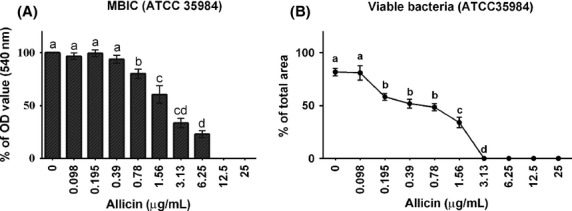
Minimum biofilm inhibitory concentration (MBIC) and viability of Staphylococcus epidermidis (ATCC 35984) within a biofilm exposed to different concentrations of allicin. (A) Results of the safranin staining method (% OD value at 540 nm wavelength, mean ± SEM). (B) Results of live/dead staining with SYTO® green and propidium iodide and quantitative evaluation with CLSM (mean ± SEM). Different letters (a–d) indicate significant (P < 0.0001) differences.